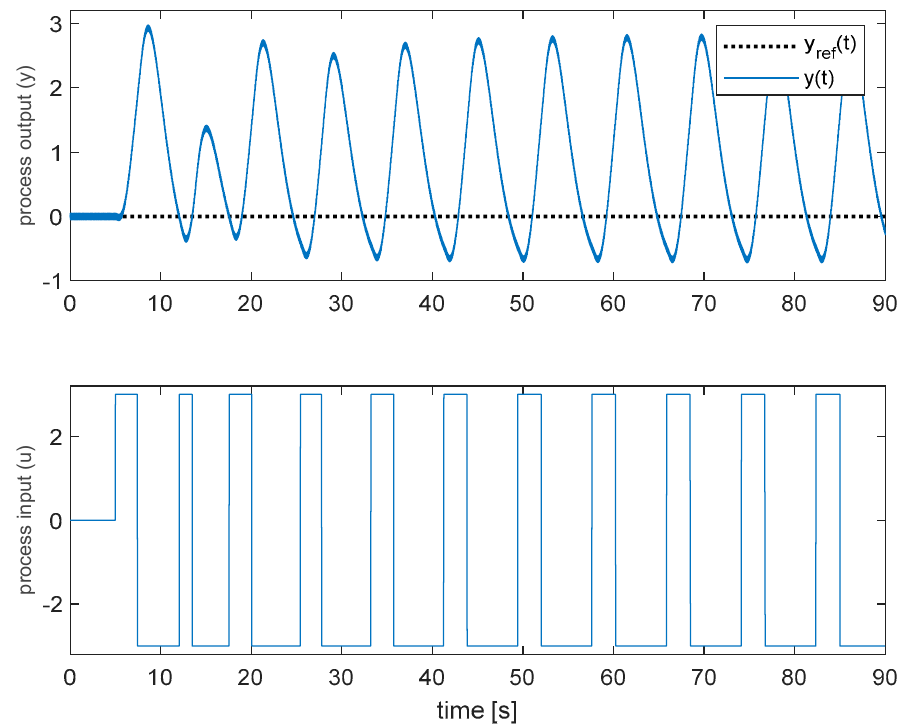
Figure 16. Response of the relay feedback method [1] combined with the time delay [7] for the non-minimum phase process with θ = 0.1 and PA set = − 3 π /4.